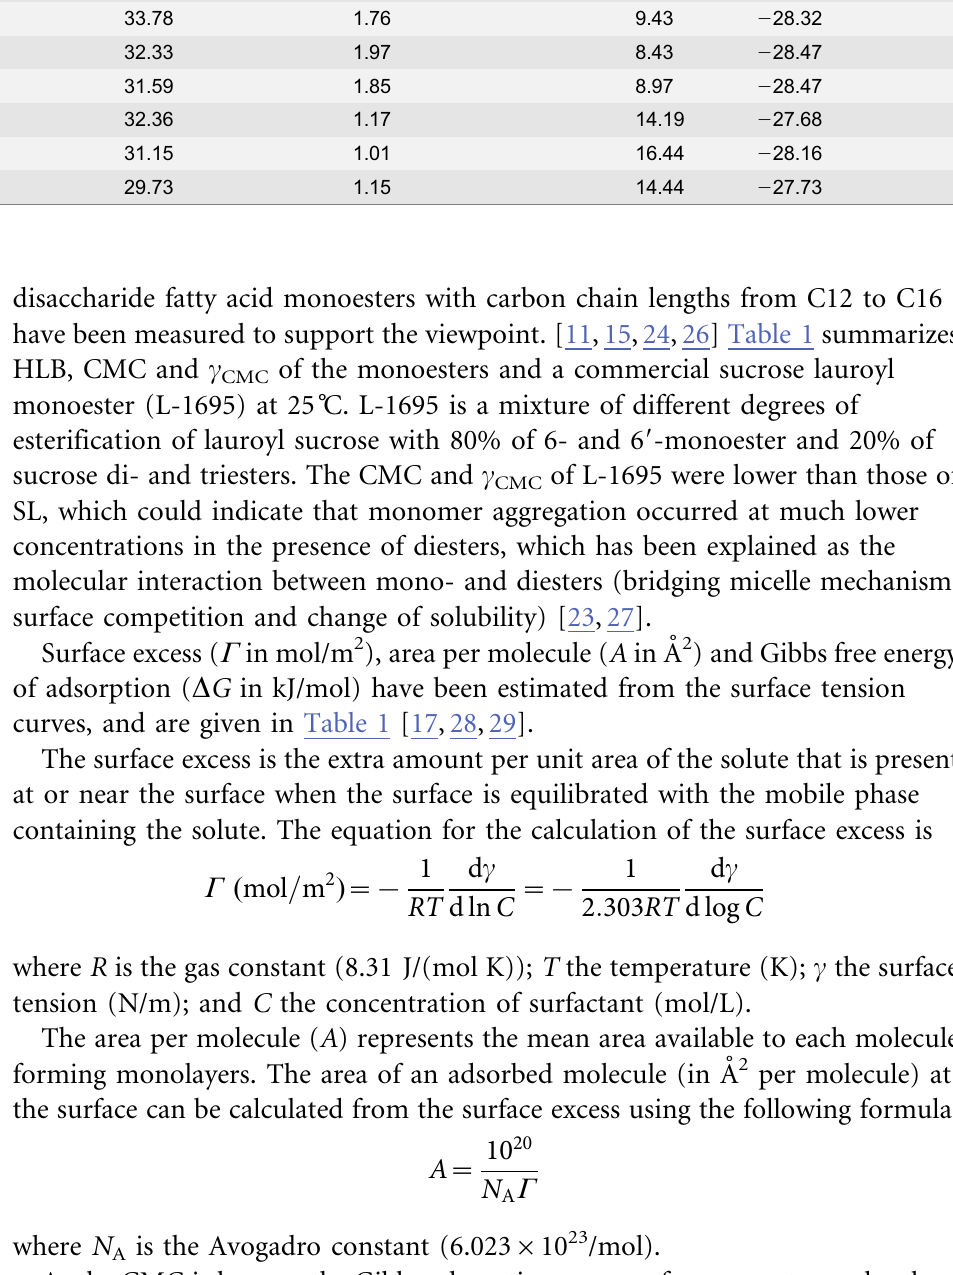
Table 1. Values of HLB, CMC, c CMC , C , A , D G estimated for sugar esters. Surfactant